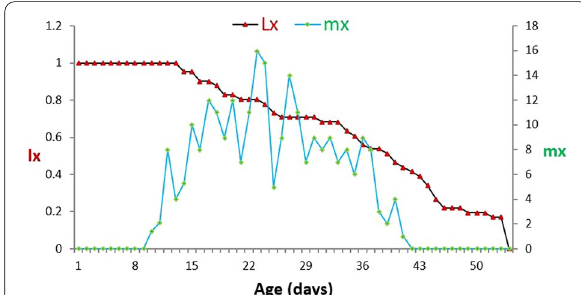
Fig. 3 Age specific survival ( l x ) and fertility ( m x ) of adult female H. dimidiata fed on R. padi aphid at 24